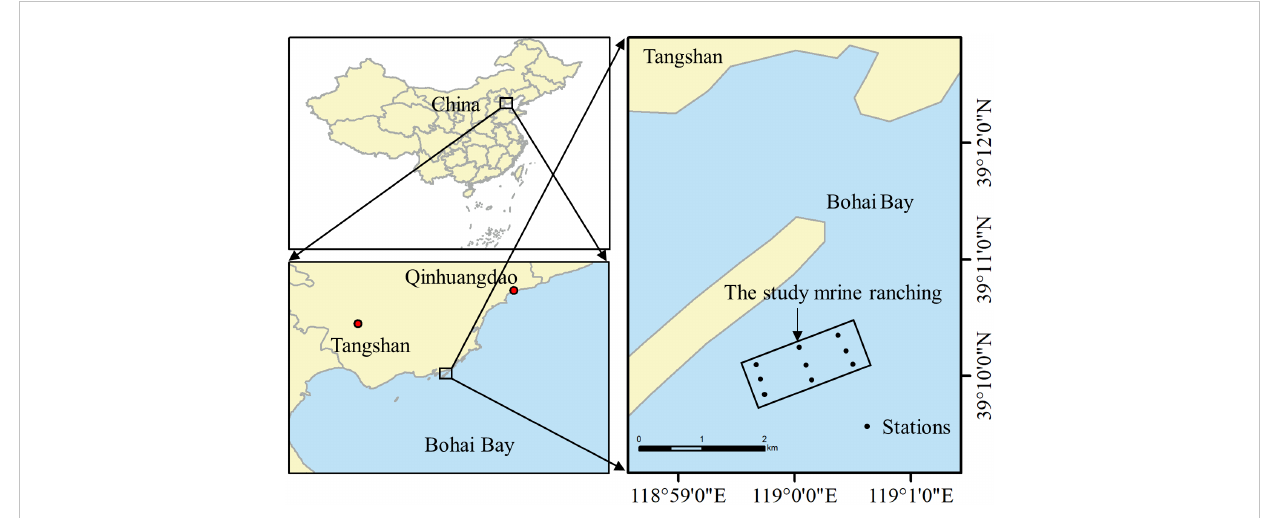
FIGURE 1 Geographical location of the arti fi cial oyster reef area in the study marine ranching in Bohai Bay,